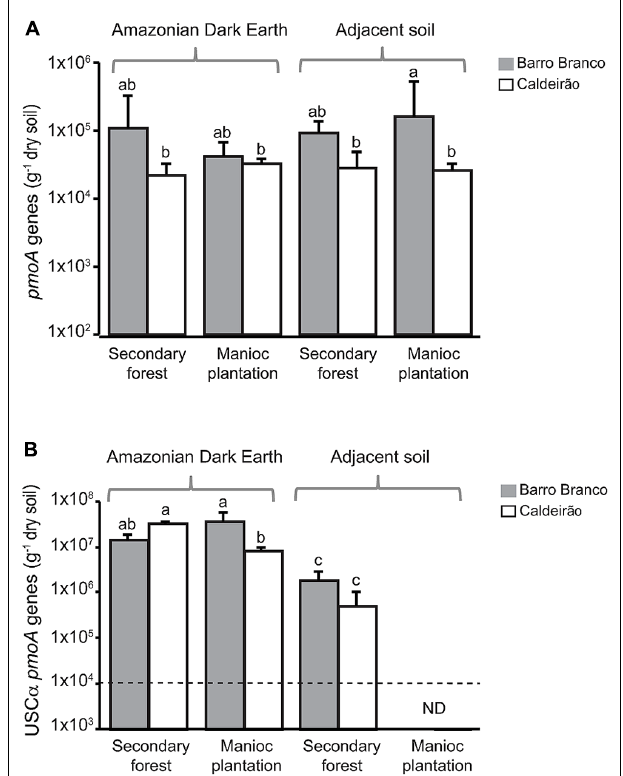
FIGURE 1 | Methanotroph pmoA abundances inAmazonian Dark Earth and adjacent soils under secondary forest and manioc cultivation at Barro Branco and Caldeirão sites. (A) Abundance of pmoA genes using the A189f-mb661r qPCR assay targeting conventional pmoA genes (i.e., mostly Methylocystis in these soils). (B) Abundance of USC α pmoA genes determined with the A189f-Forest675r qPCR assay. Abundances denoted with different letters above the bars are significantly different from each other (Tukey’s HSD, p < 0.05). ND indicates that the target gene was below the detection limit of the qPCR assay, which is indicated by the dashed